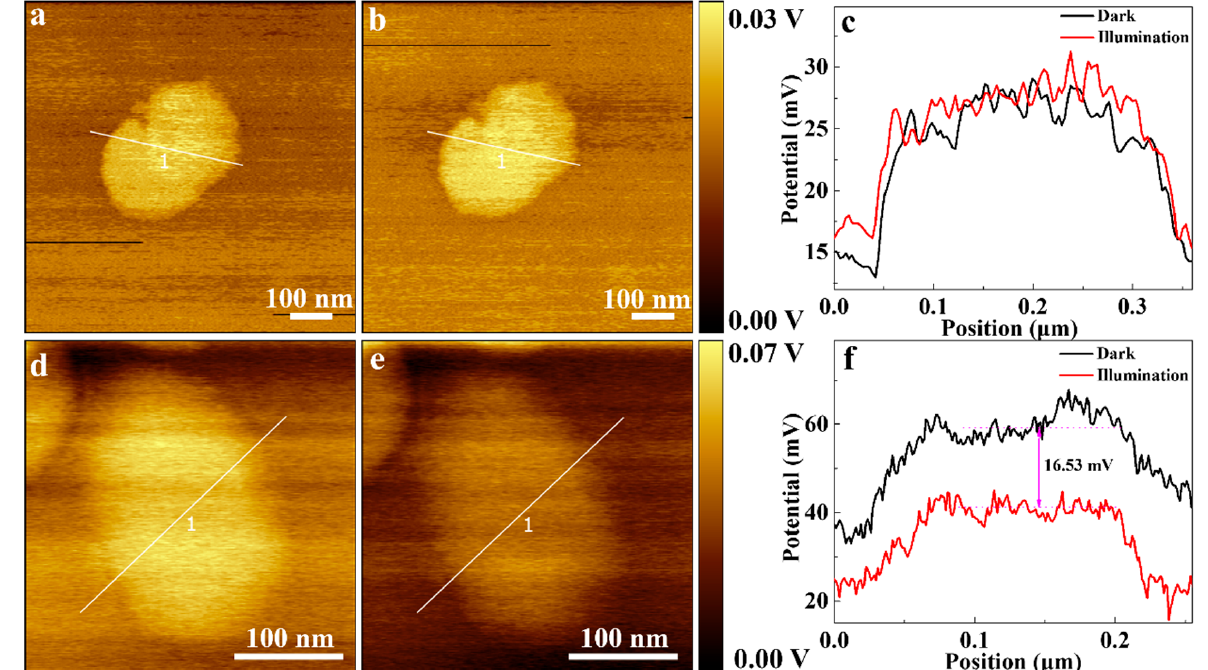
Figure 3. The surface potential of CNs in different conditions, ( a ) in the dark and ( b ) under illumination; ( c ) The surface potential curves along the white lines in ( a , b ). The surface potential of CNs/GQDs-3 ( d ) in the dark and ( e ) under illumination; ( f ) The surface potential along the white lines in ( d , e ).